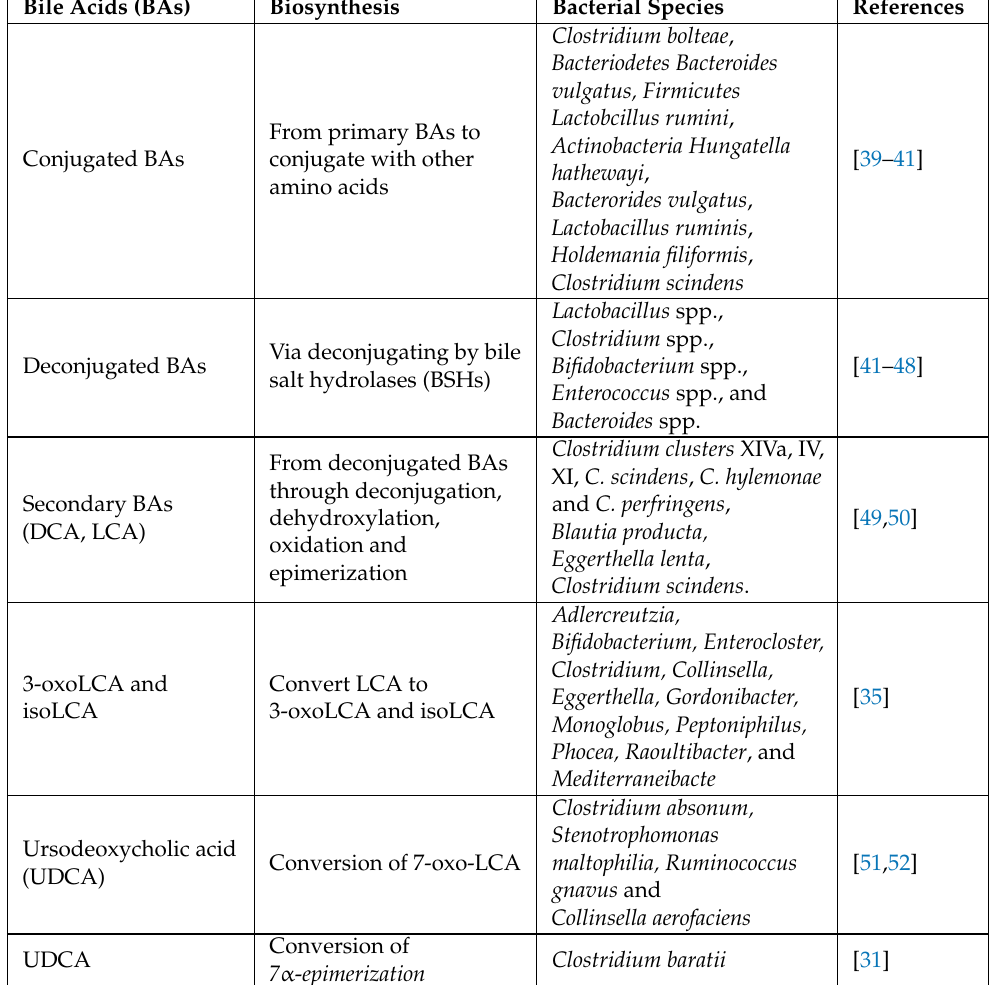
Table 3. Gut microbiota species and bile acid